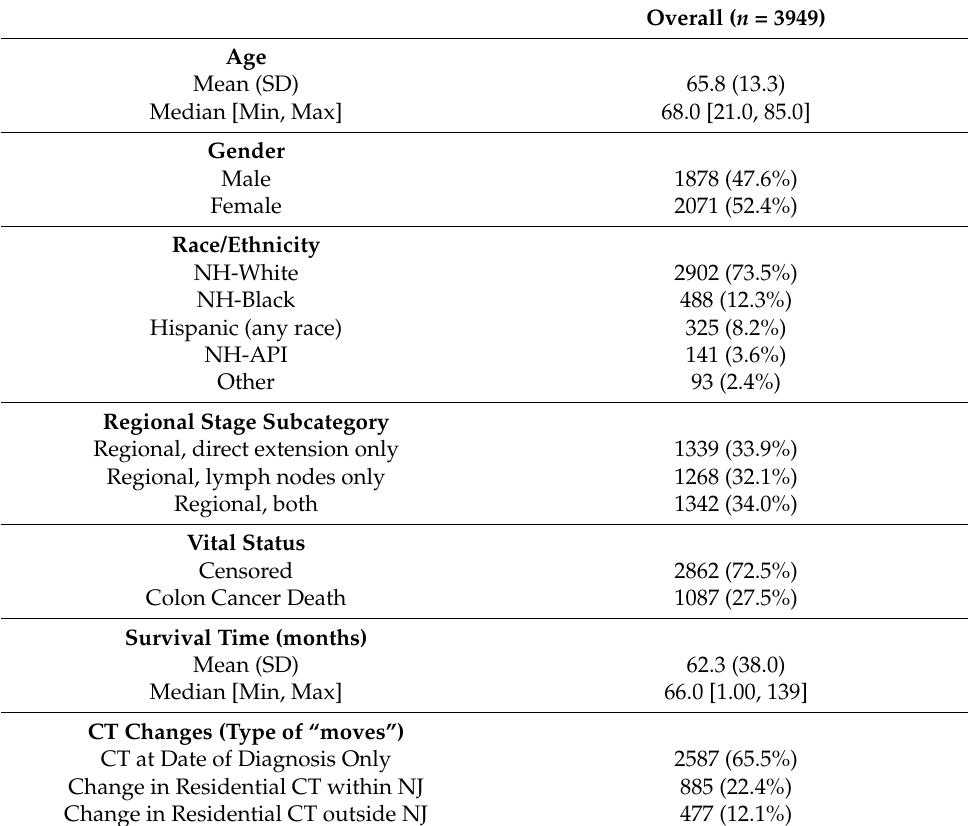
Table 3. Study population